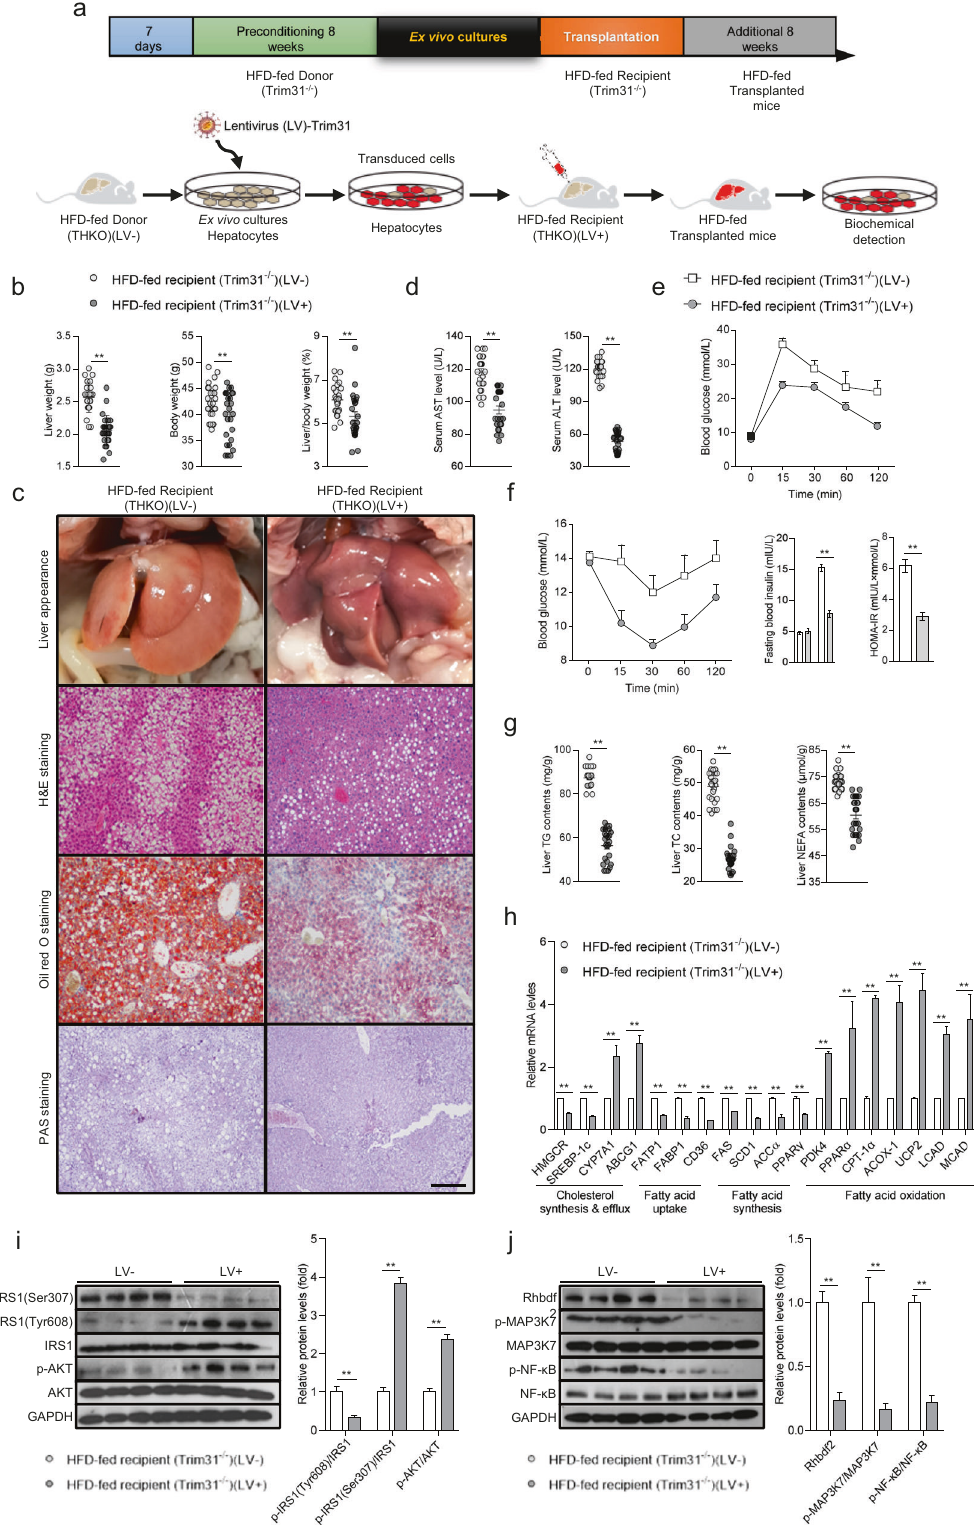
assays demonstrated that RHBDF2 co-precipitated with TRIM31 WT, TRIM31 RING Δ , and TRIM31 Box Δ . These results indicated that the CC domain contributes to binding to RHBDF2. Next, three vectors encoding HA-tagged truncated RHBDF2 mutants, including wild-type (RHBDF2-HA WT), a